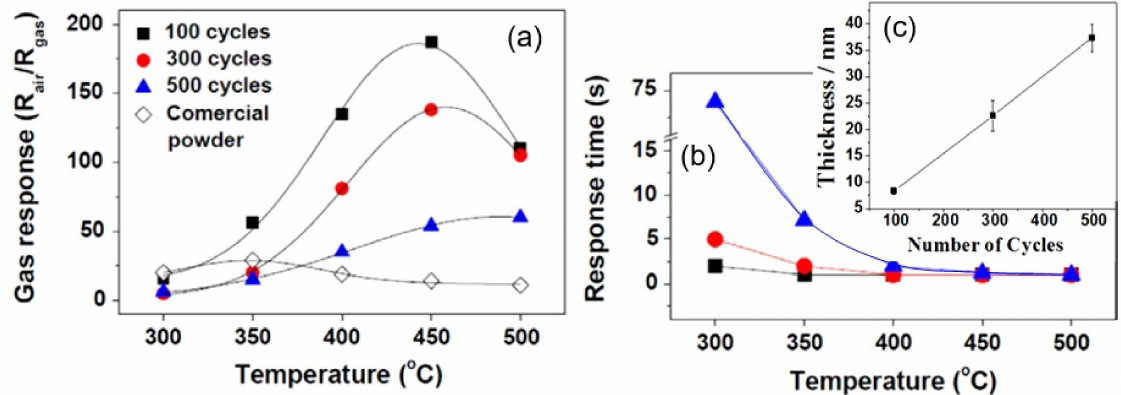
Figure 11. Effect of wall thickness of hollow SnO 2 nanofibers on the ( a ) magnitude of the response to 100 ppm ethanol and ( b ) response time as a function of operation temperature; ( c ) dependence of the SnO 2 film thickness on the number of PEALD cycles. Adapted with permission from [181]. Copyright 2010 IOP.